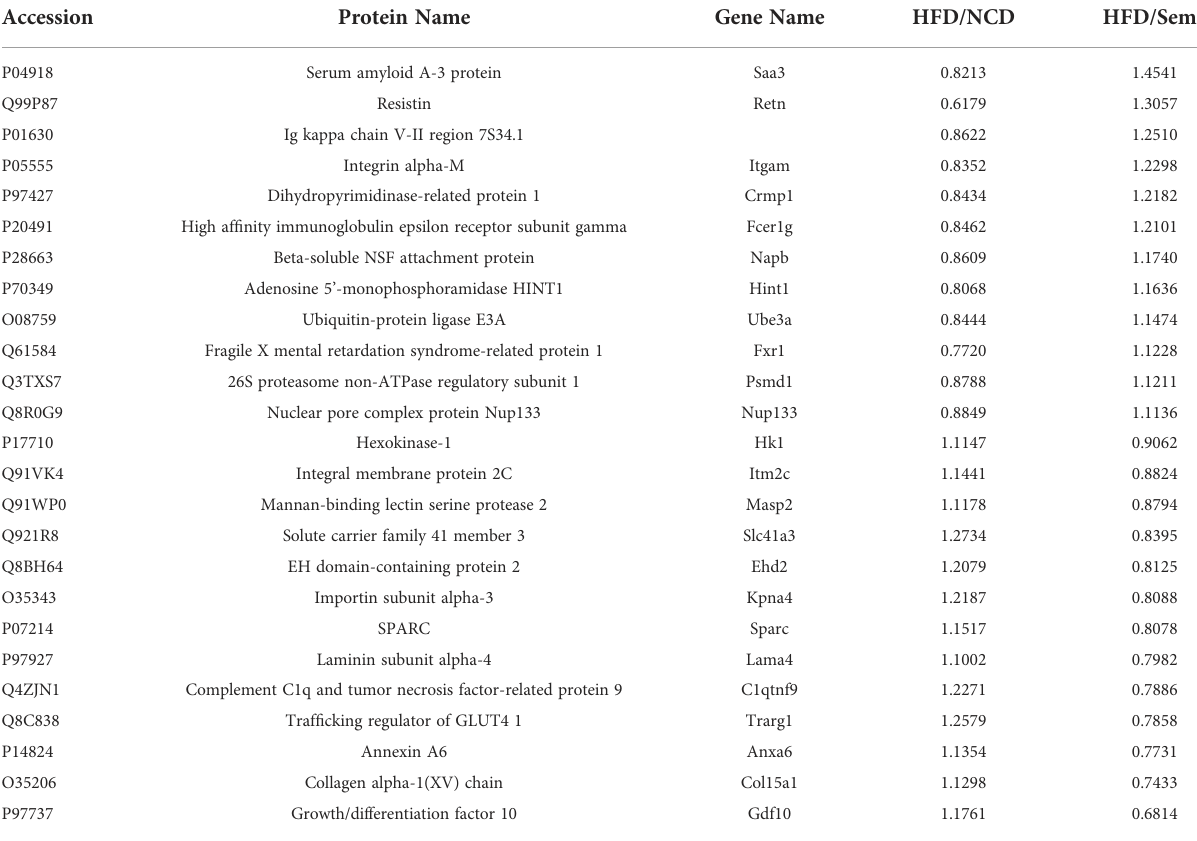
TABLE 1 The DEPs between HFD/NCD and